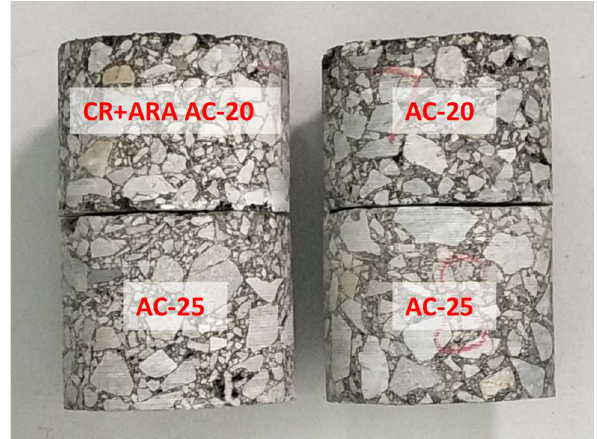
Figure 6. Core samples from the field pavement: ( left ) CR-modified anti-rutting mixture, and ( right ) normal AC-20 mixture.